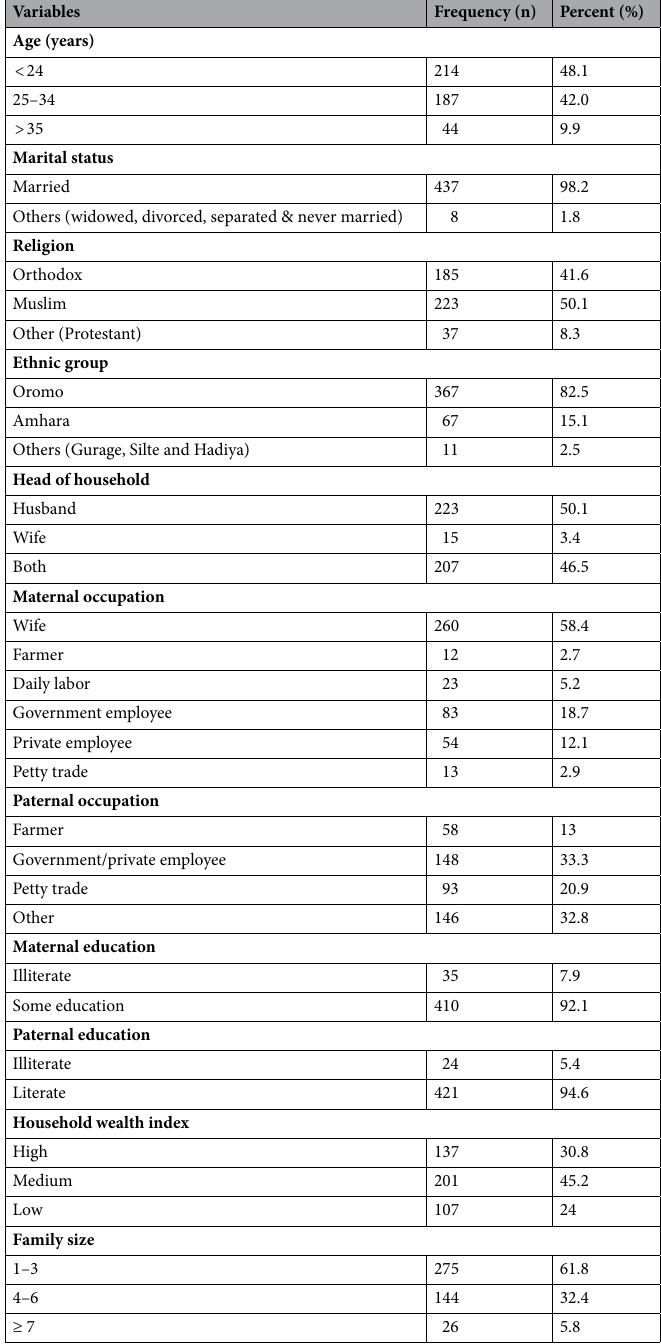
Table 1. Socio-economic and demographic characteristics of pregnant women attending antenatal care at Robe Town, Bale zone, Southeast Ethiopia, 2015 (n =